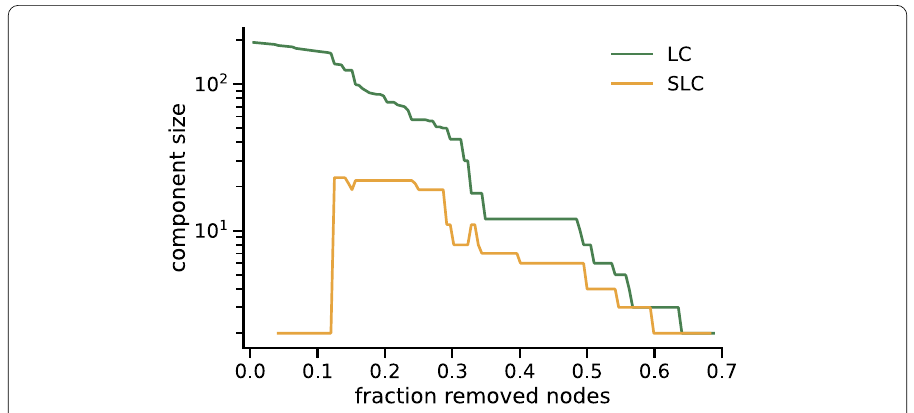
Figure 5 Size of the largest LC q (green) and second largest SLC q (orange) connected component as a function of the percentage q of removed nodes. Nodes are removed starting from those who have the